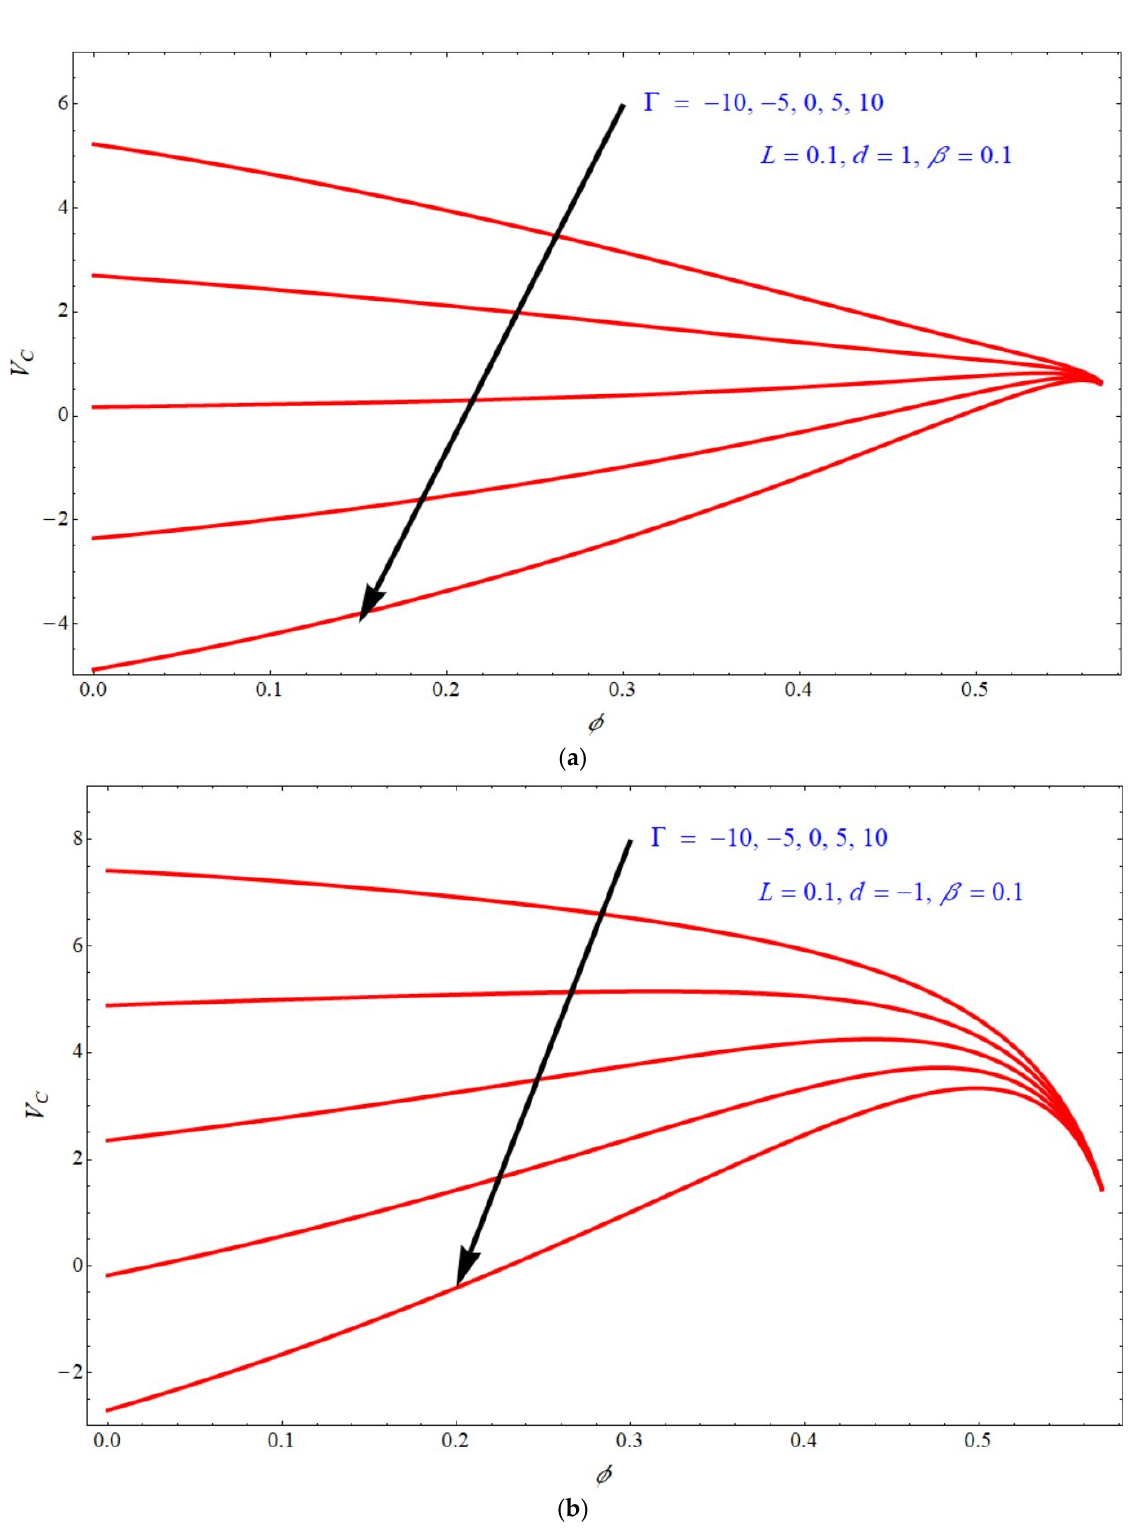
Γ at ( a ) d = 1 and ( b ) d = −